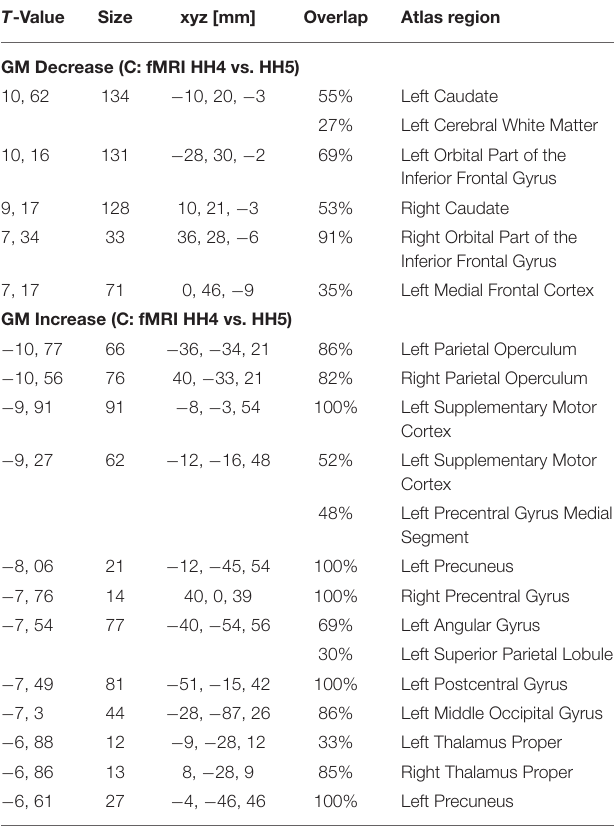
changes in the experiments C of the Hamburg data (fMRI).